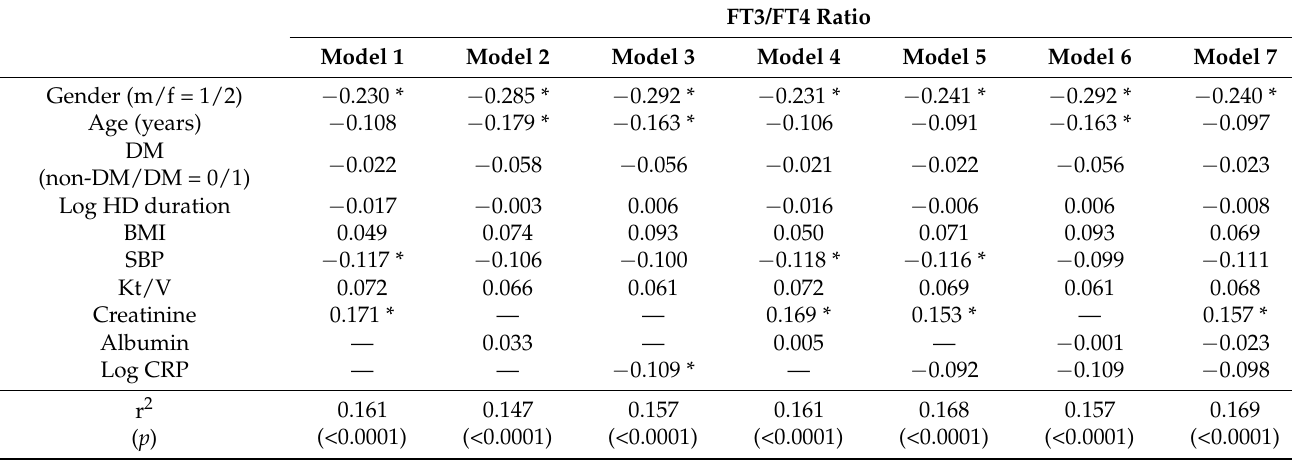
Figure 2. Correlation of serum FT3/FT4 ratio with ( A ) serum creatinine, ( B ) log10 CRP, ( C ) serum albumin, and ( D ) serum total cholesterol in 332 hemodialysis patients. Serum FT3/FT4 ratio was significantly correlated in a positive manner with serum creatinine ( A ) and in a negative manner with serum log10 CRP ( B ). In addition, it showed a tendency towards a positive correlation with serum albumin ( C ), while a significant and inverse correlation with serum total cholesterol was found ( D ). Table 2. Multivariate analysis of factors associated with serum FT3/FT4 ratio in euthyroid hemodialysis patients ( n =